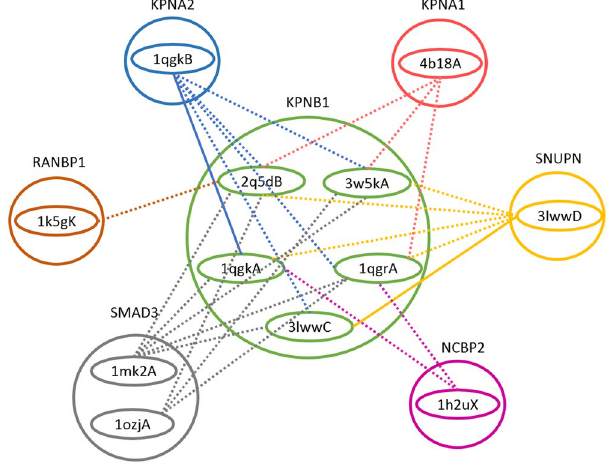
Figure 8. KPNB1’s existing and predicted interactions by PRISM. Interactions having the complex structures in PDB database are shown with solid lines. Dotted lines indicate the PRISM